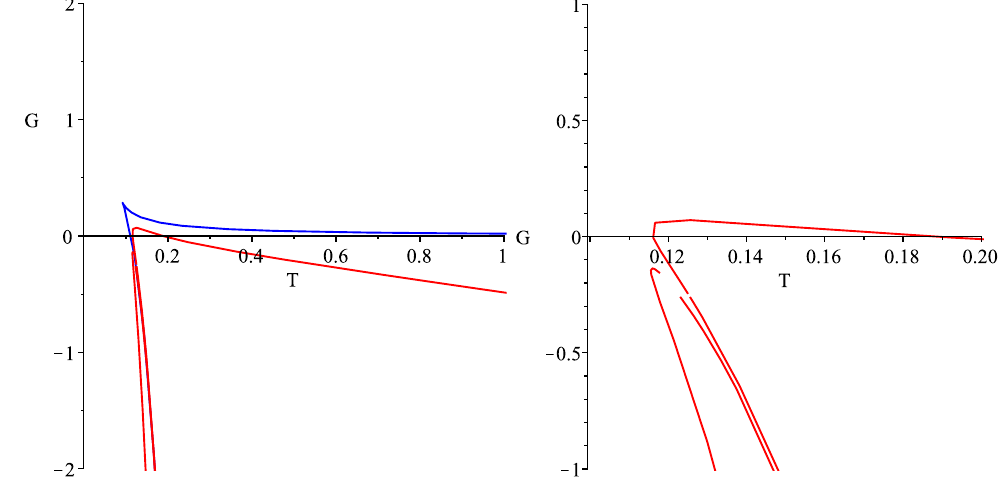
Figure 19 . Free energy for various fixed ψ N . We set e = g = 0 and ‘ = 3 . The upper blue curve corresponds to ψ N = 0 , the lower red curve to ψ N = 0 . 2 . The right hand diagram is a close-up of the ψ N = 0 . 2 case, exhibiting the fractured